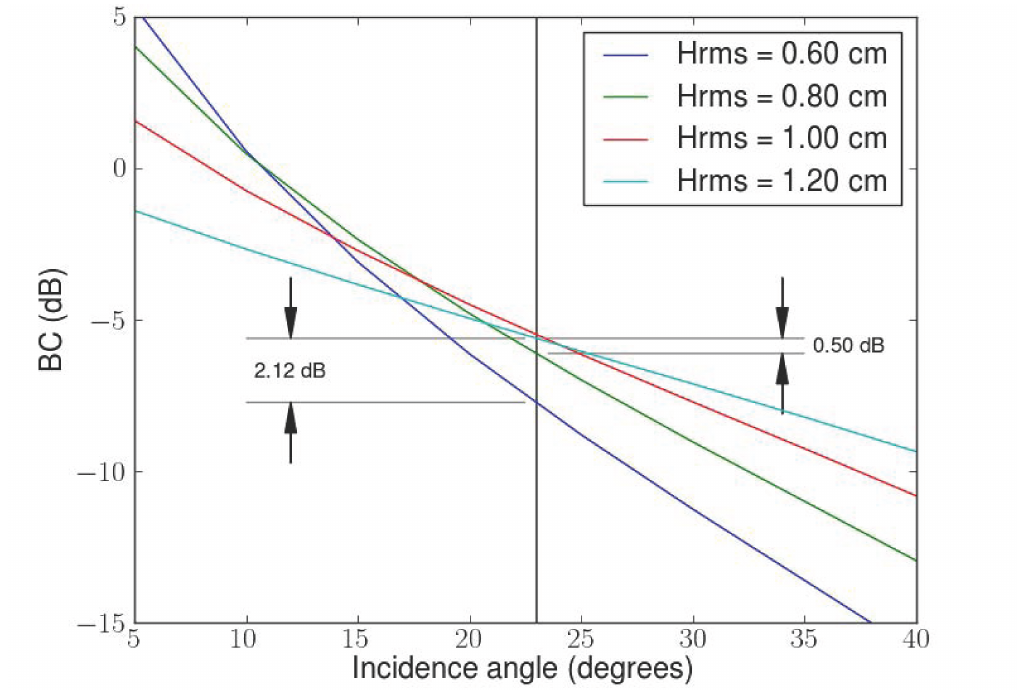
in terms of incidence angle and H HH